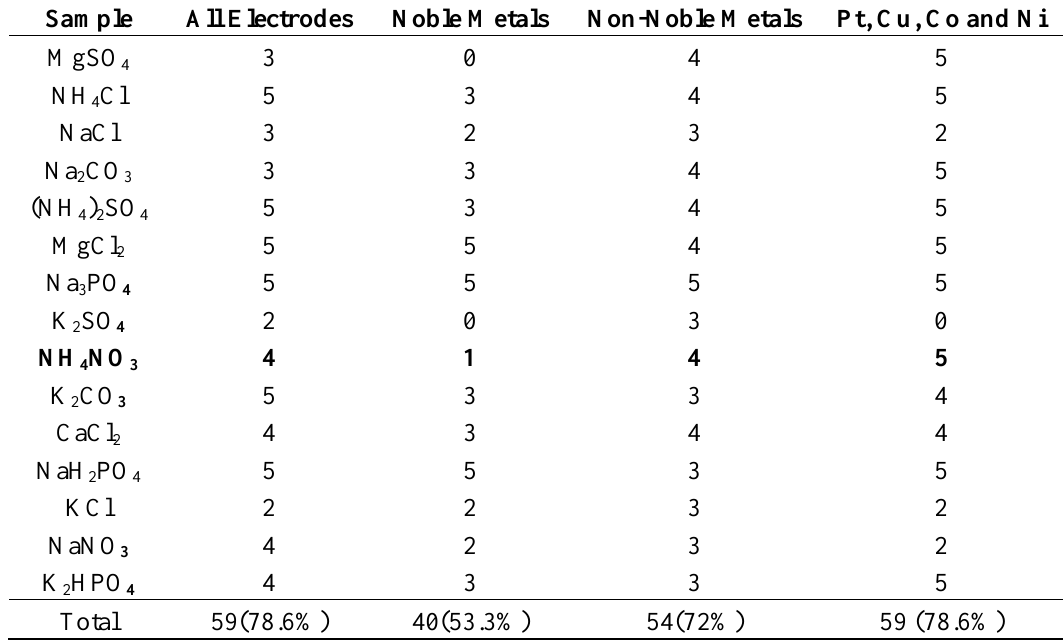
Table 2. Number of successful in the discrimination of several salts using different combination of